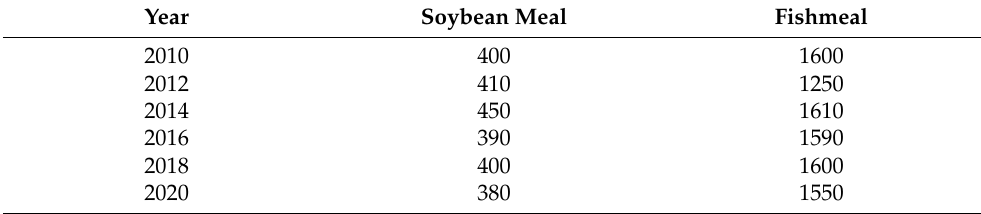
Table 8. Soybean meal and fishmeal prices over the past decade